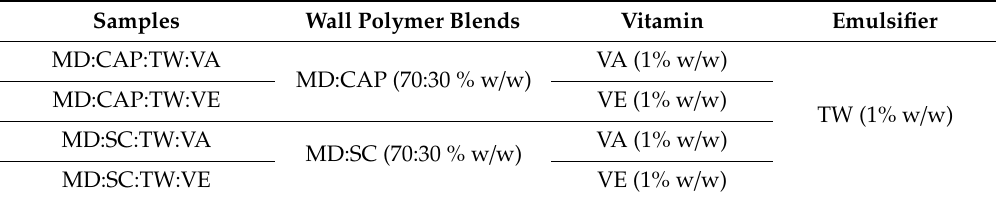
Table 4. Summary of the formulations achieved. Components: Maltodextrin (MD), Capsul ® (CAP),